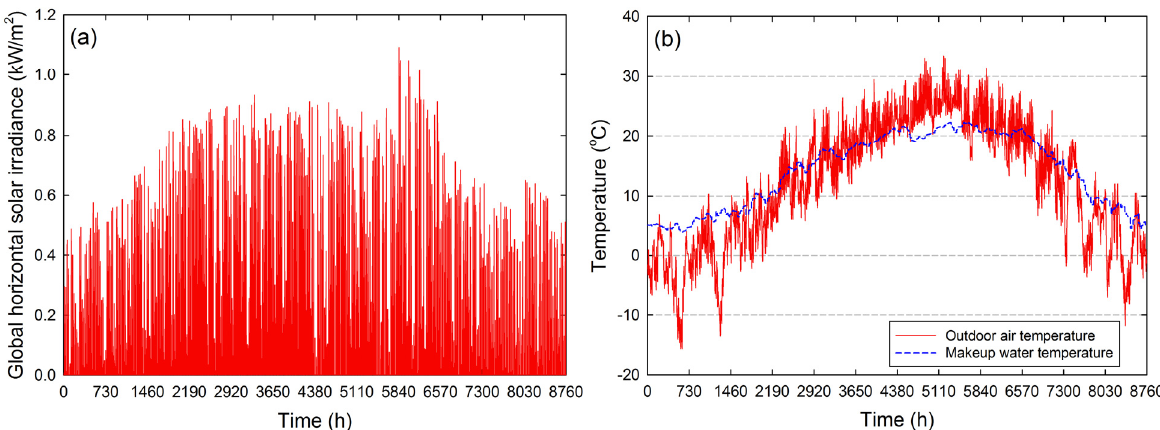
Figure 3. ( a ) Hourly global horizontal solar irradiance, and ( b ) outdoor air temperature and make-up water temperature over one year for Incheon, South